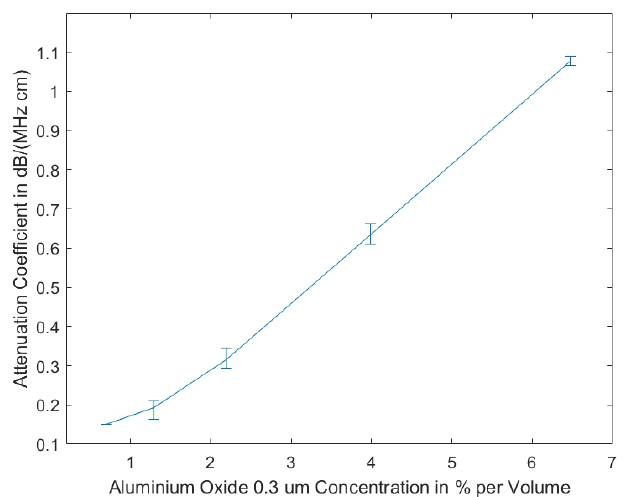
Figure 2. Attenuation coefficient vs. concentration of aluminum oxide (grain size 0.3 µ m) for homogeneously prepared tissue mimicking phantoms (as shown in Figure 1b). Reprinted from ref.